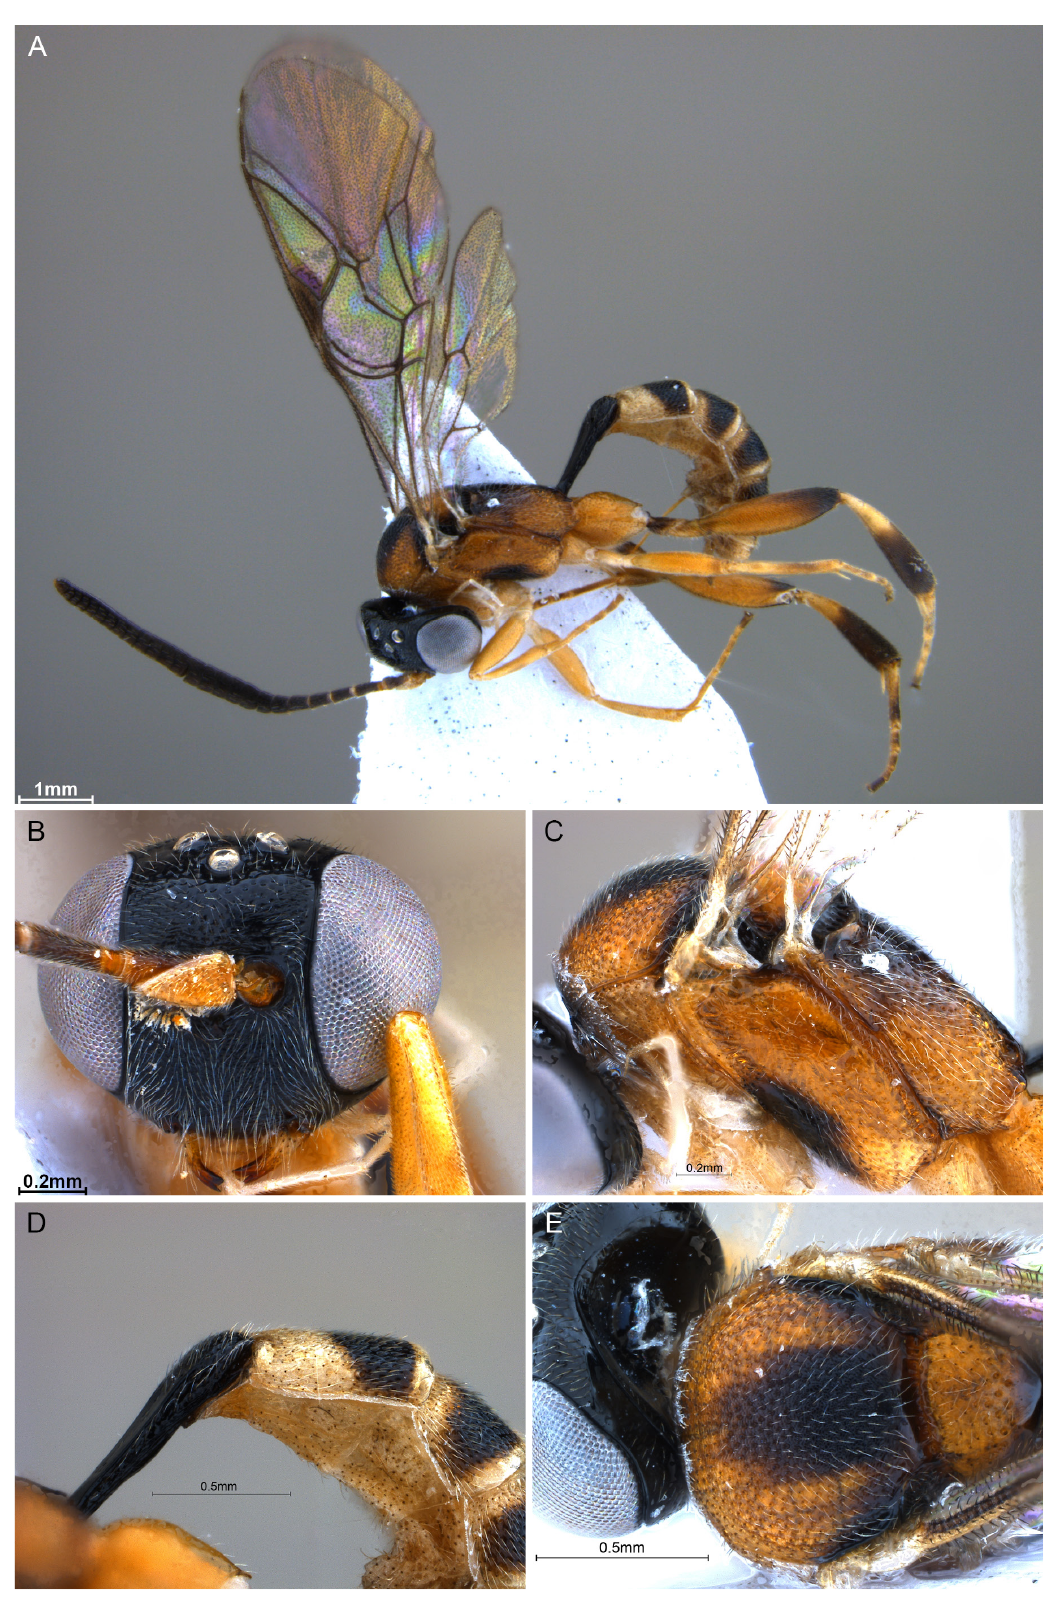
Fig. 5. Palpostilpnus aki sp. nov., holotype, ♀ (KIZ). A . Lateral habitus. B . Head, anterior view. C . Mesopleuron. D . T1–T3, lateral view. E .